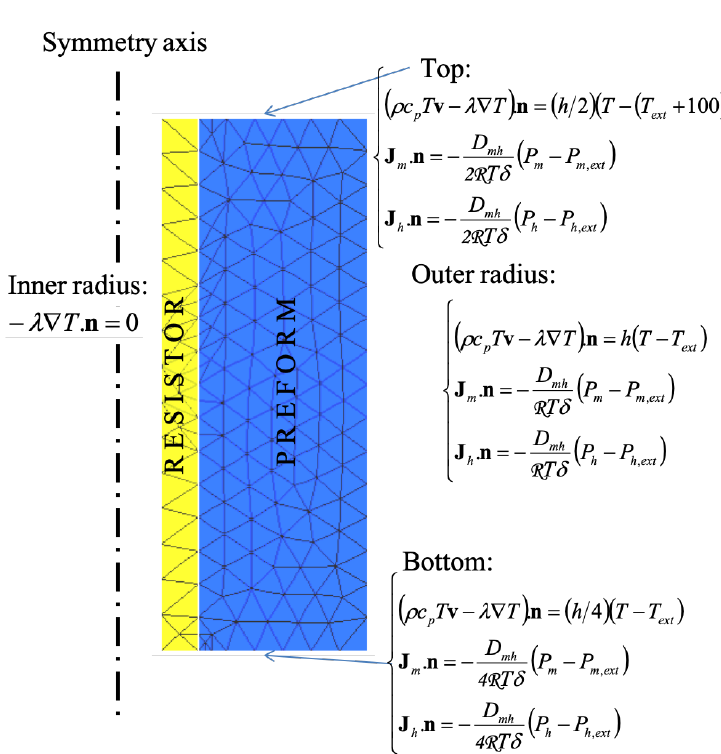
Figure 11. Geometry and boundary conditions for the